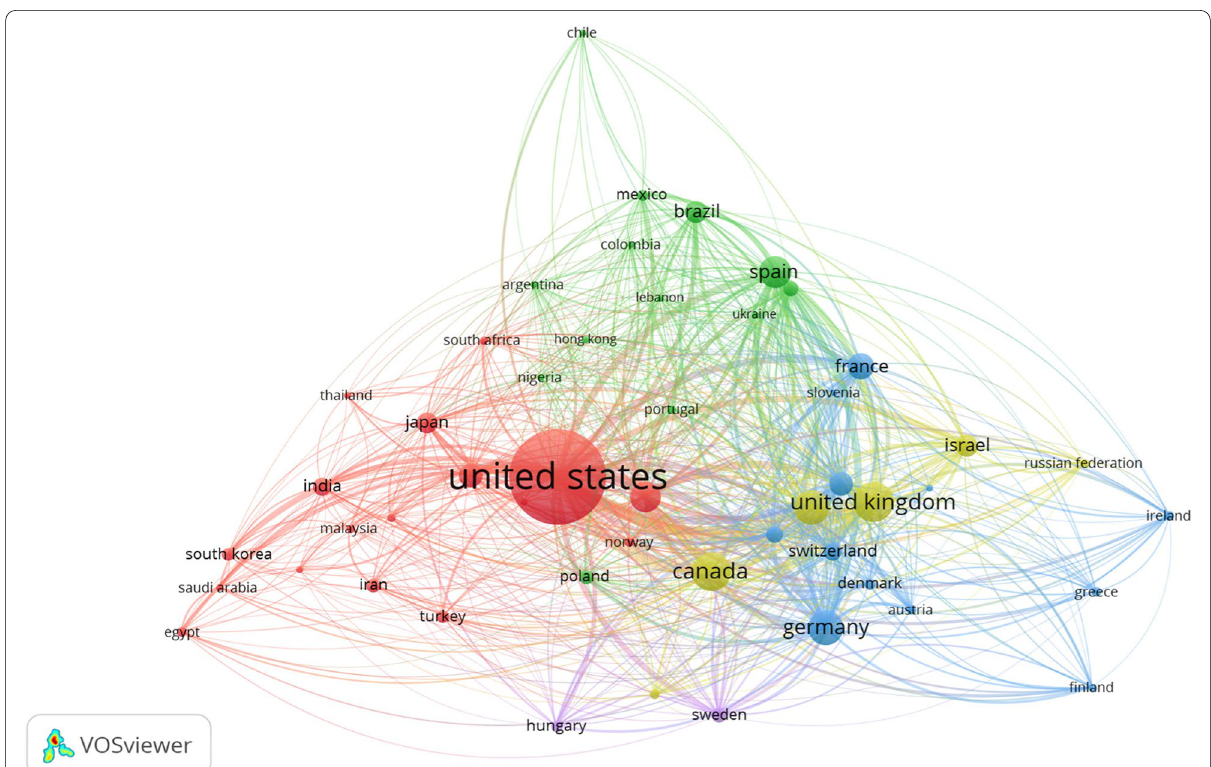
Fig. 3 Co-authorship analysis of the 50 most productive countries with respect to cannabis and cannabinoid research. The number of edges connecting two nodes visually quantifies the level of collaboration between researchers or institutions in different countries. Data was collected from Scopus, and the VOSviewer software tool was used to generate the bibliometric